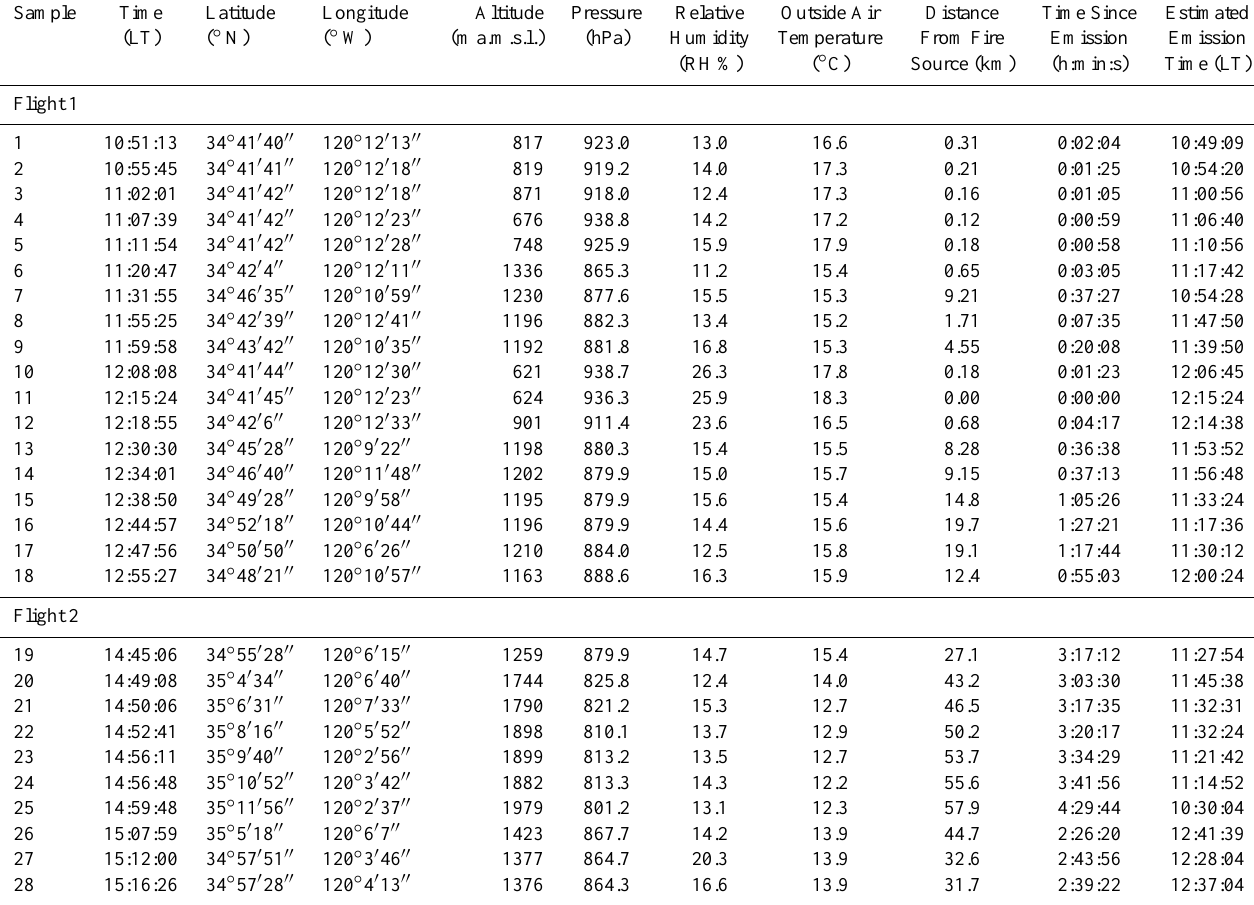
Table 1. Smoke samples from the Williams Fire obtained during Flights 1 and 2.